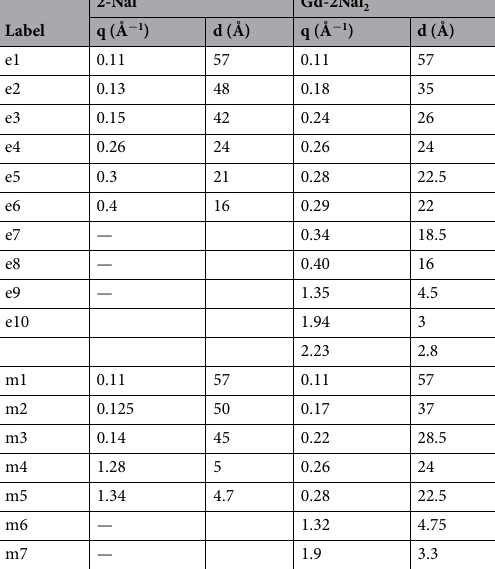
Table 1. q positions, and corresponding d = 2 π /q values, of meridional and equatorial reflections for the 2-Nal and Gd-2Nal 2 fibers. The error on the d values amounts to ± 0.3